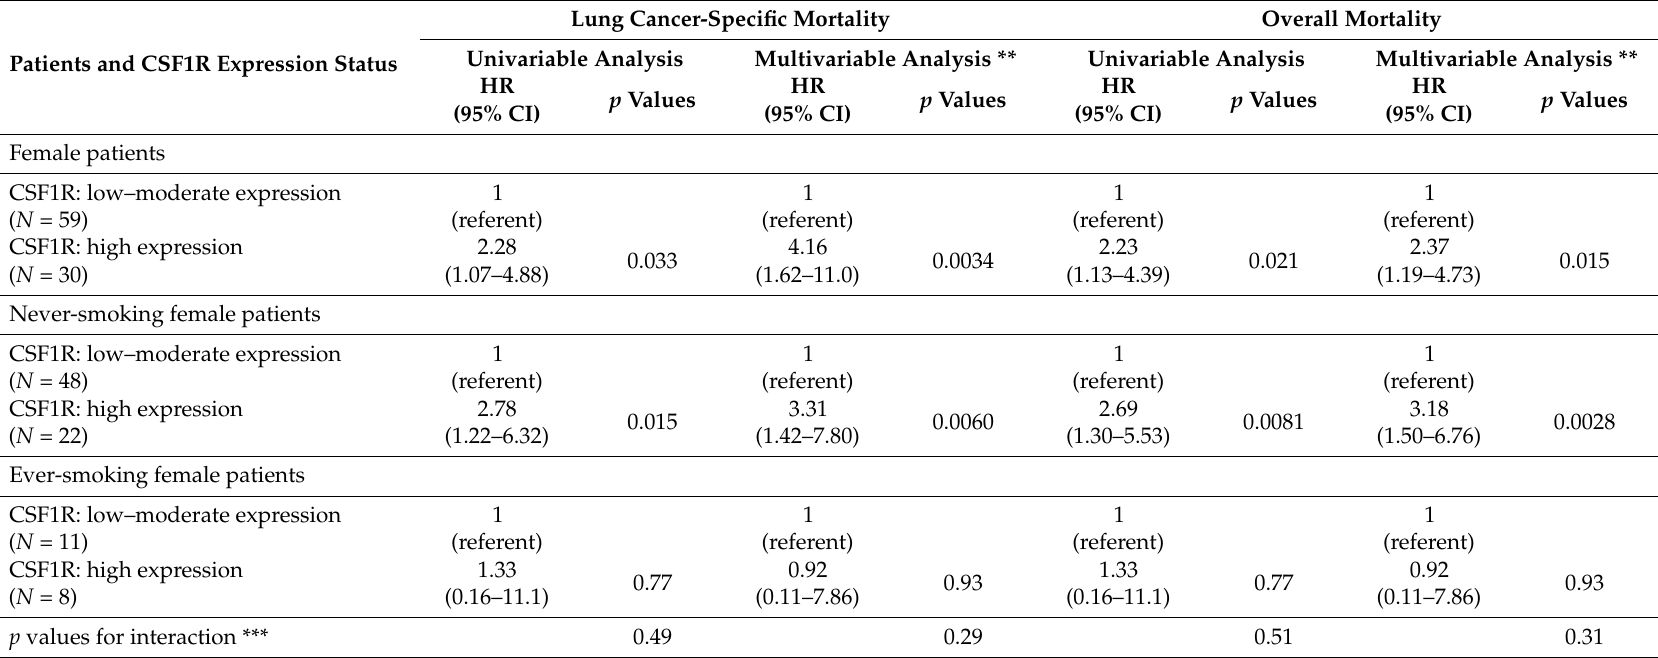
Table 3. CSF1R expression in tumor-associated macrophages and female patient mortality * in lung adenocarcinoma, stratified by smoking status. Lung Cancer-Specific Patients and CSF1R Expression Status